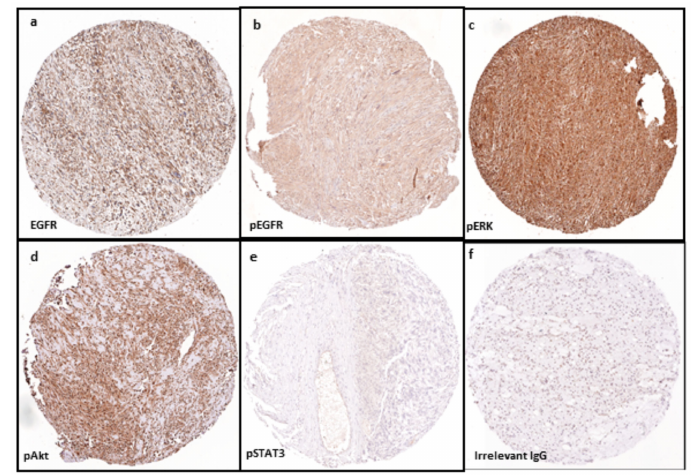
Figure 1. Expression of protein markers using tissue microarray technology and immunohistochemistry in a sample of leiomyosarcoma (LMS) cores (amplification × 100): ( a ) positive expression (brown colour) of total EGFR; ( b ) phosphorylated EGFR; ( c ) pERK; and ( d ) pAkt in tissue array of LMS specimen. In contrast, negative immunohistostaining (blue colour) is shown in detection of: ( e ) pSTAT3 in LMS; and ( f ) control sarcoma sample (irrelevant IgG). Abbreviations: EGFR, epidermal growth factor receptor; pEGFR, phosphorylated EGFR; pERK, phosphorylated extracellular signal-regulated kinase; p-Akt, phosphorylated protein kinase B; pSTAT3, phosphorylated signal transducers and activators of